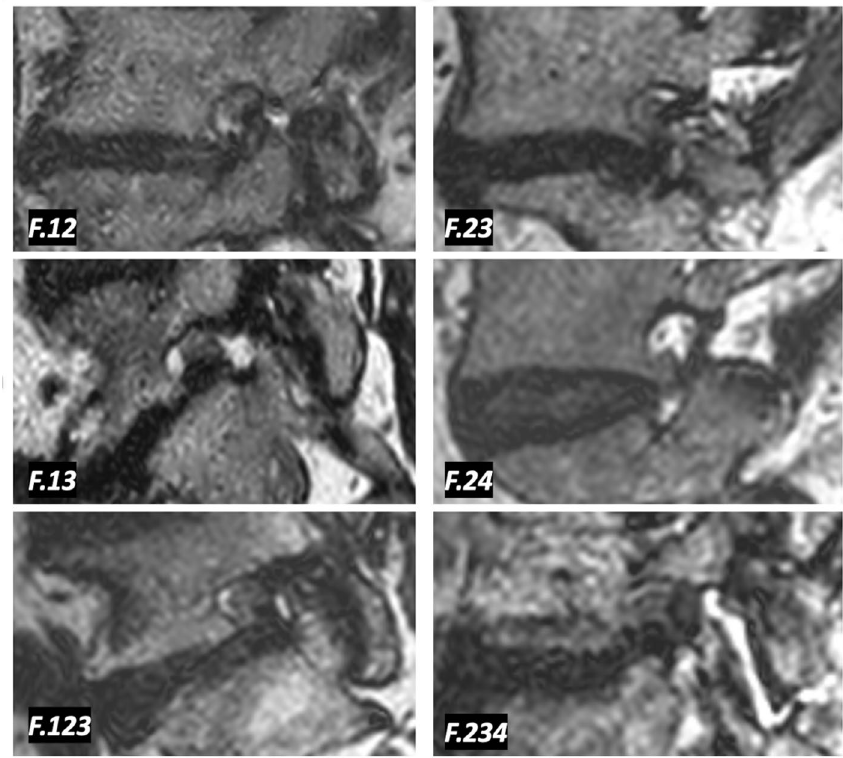
Figure 3. Representative imaging examples of grade F lumbar foraminal